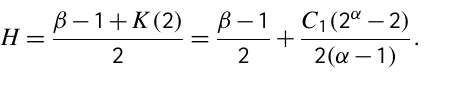
simulation. The procedure leads to a final value, ˆ α = 1 .